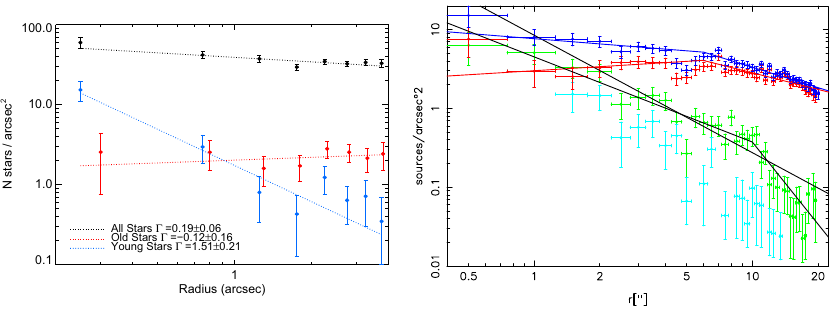
Fig. 47 Number of sources per arcsec 2 as a function of radius from the Galactic Centre in seconds. Images reproduced with permission from (left) Do et al. (2009), copyright by AAS; and (right) Buchholz et